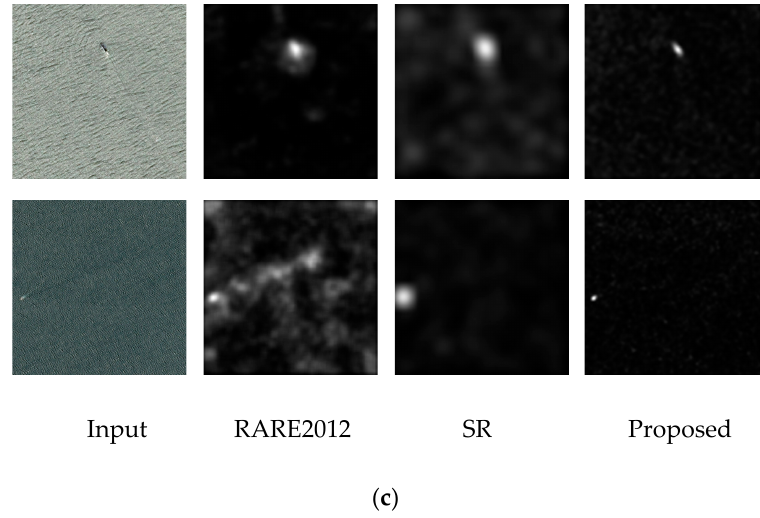
Figure 10. Qualitative comparison of the saliency models in different types of backgrounds. ( a ) The calm sea. ( b ) The cloud cover. ( c ) The strong sea clutters. SR: spectral residual.